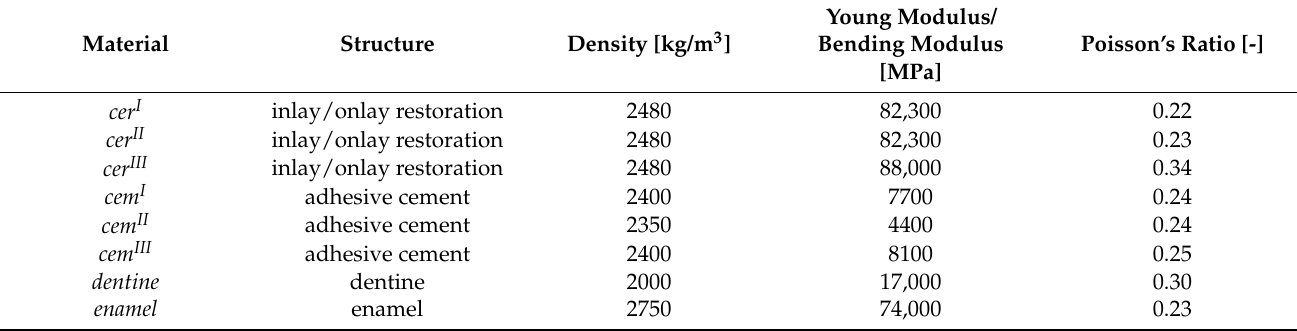
Table 2. Mechanical properties of considered dental